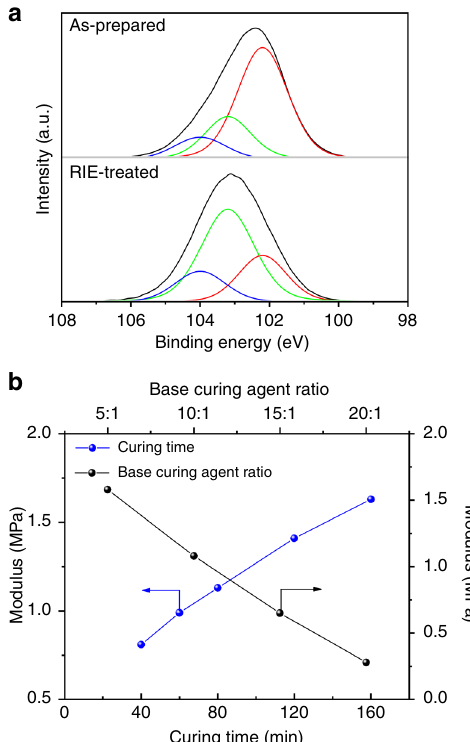
Fig. 3 Mechanism investigation on the control of RIE-induced nanostructures. a The binding energy of the Si 2p peak and fi tted components. Top: as- prepared PDMS. Bottom, the RIE-treated PDMS. b The storage modulus of PDMS after the thermal pretreatment. The pretreatment condition for PDMS with different weight ratios of the base to curing agent: 80°C, 80min. The thermal pretreatment condition for PDMS with a 10:1 weight ratio: 80°C and varied